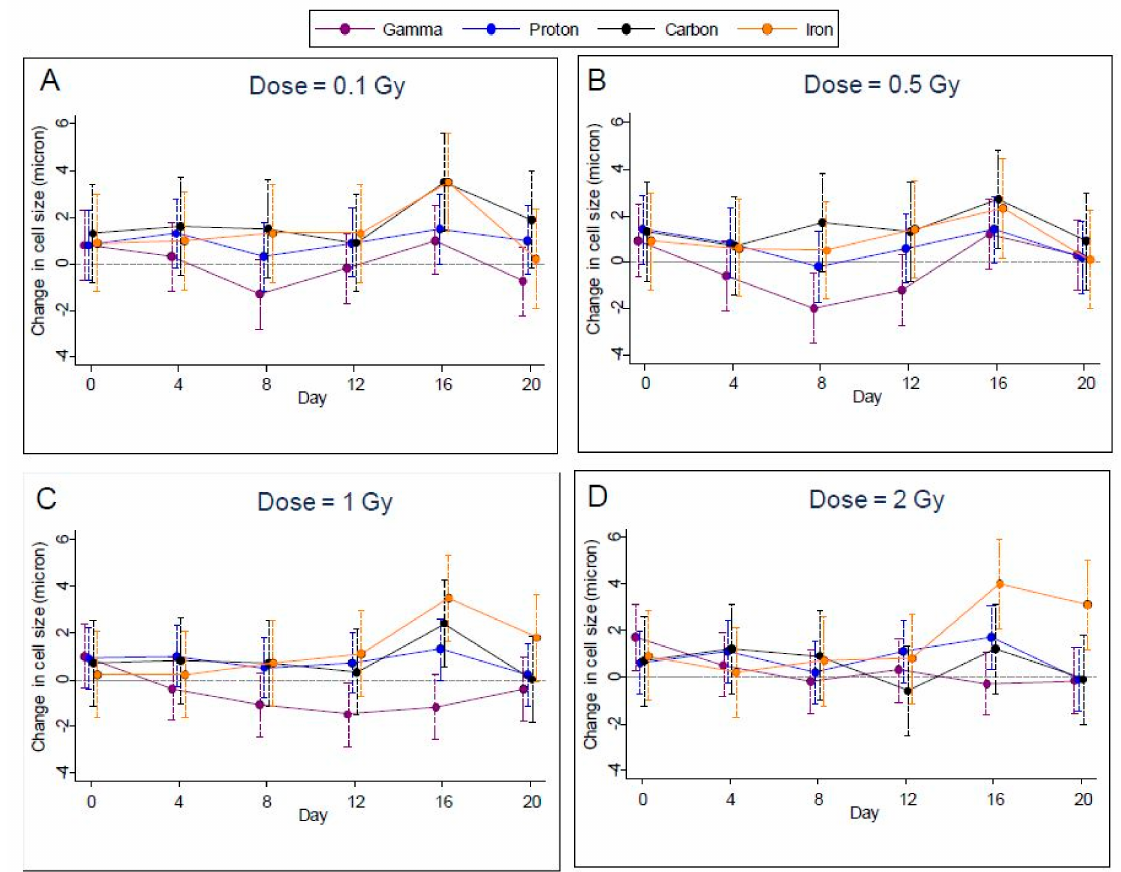
Figure 5. Change in cell size compared to controls following gamma, proton, carbon, and iron radiation treatments at different dosages ( A ); 0.1, ( B ); 0.5, ( C ), 1.0 and ( D ), 2.0 Gy with 95% confidence limits